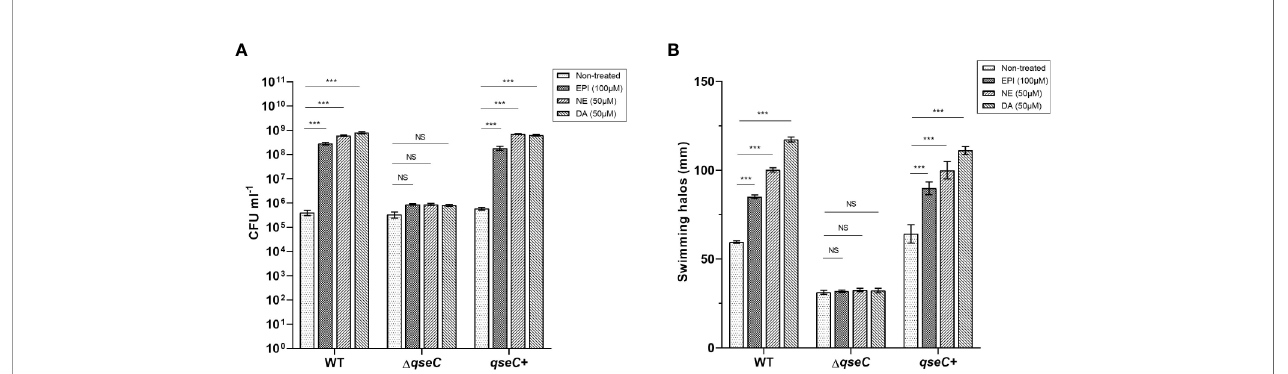
FIGURE 1 | QseC mediates catecholamine-induced growth and fl agellar motility in Vp AHPND strains. (A) Viable counts of Vp AHPND wild type 123, D qseC mutant and complementary strain qseC + after 48 h of incubation from an inoculum of 10 2 CFU ml -1 in serum-SAPI medium with catecholamines; (B) Sizes of motility halos after 18 h of incubation on TSA30 plates containing 0.3% agar with different catecholamines. Epinephrine (EPI), norepinephrine (NE) and dopamine (DA) were used at 100, 50, and 50 µM, respectively. Error bars represent the standard deviation of three independent cultures. Asterisks indicate signi fi cant differences when compared to untreated Vp AHPND (independent samples t- test; * p < 0.05; ** p < 0.01; *** p <